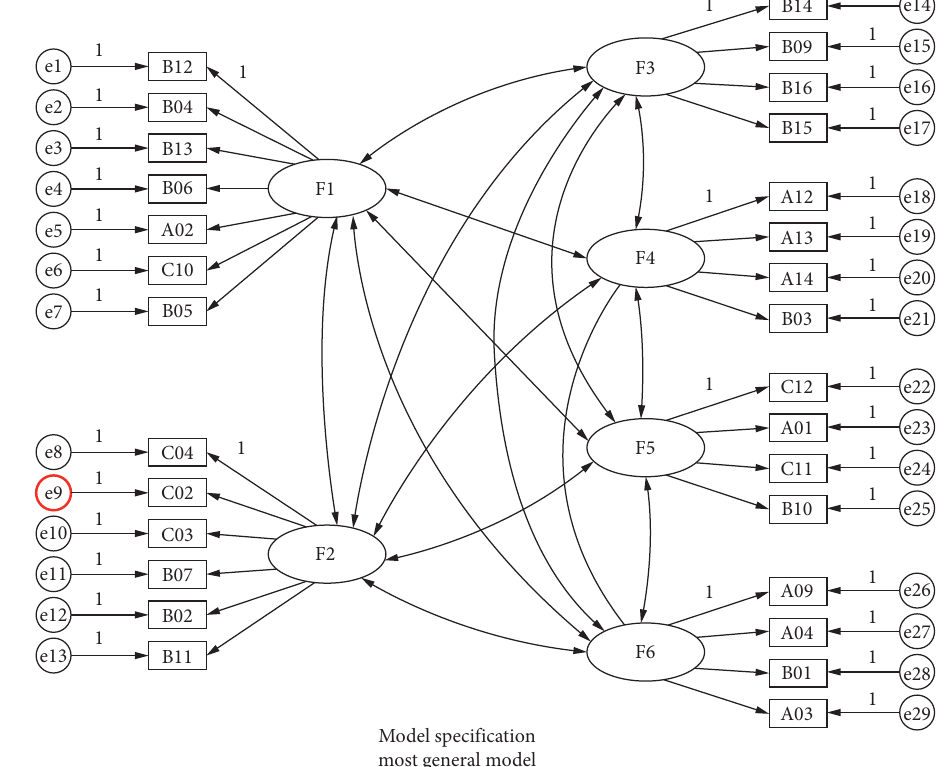
Figure 1: Theoretical structural equation modeling (SEM) model of the internal